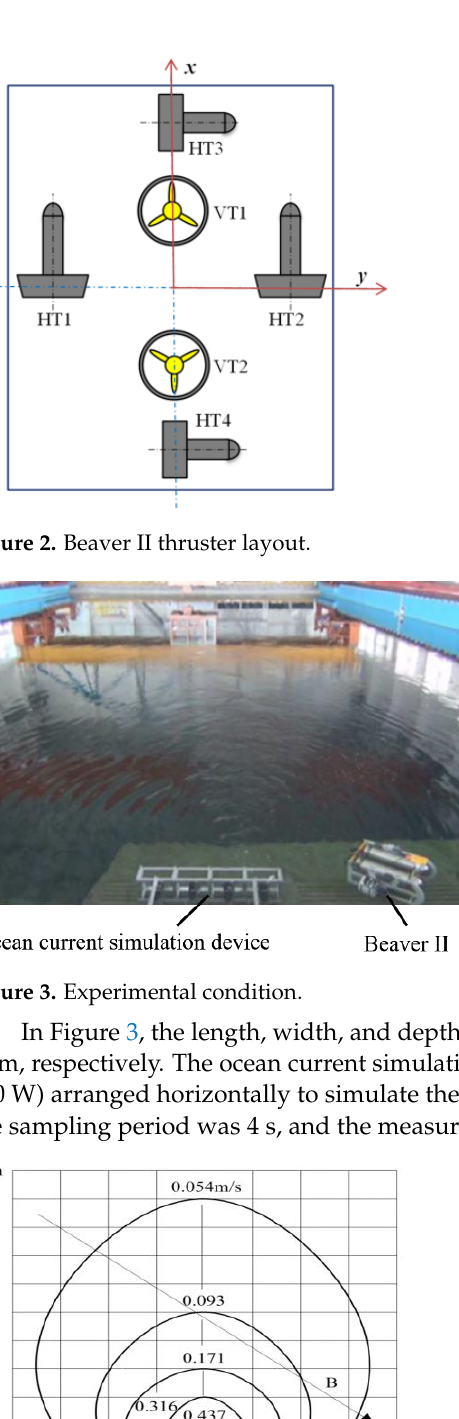
Figure 3. Experimental condition.